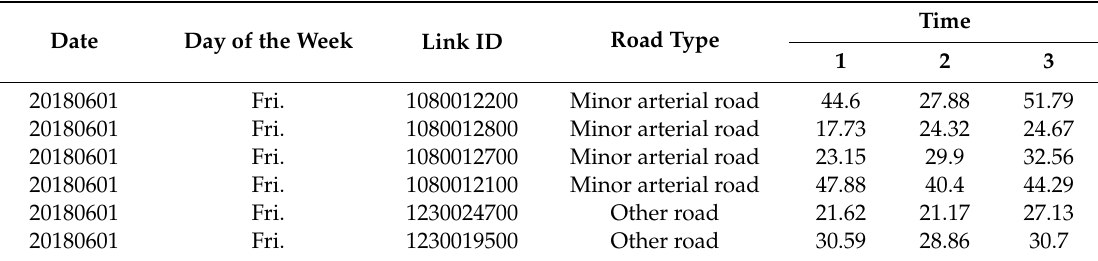
Table 2. Sample of TOPIS speed